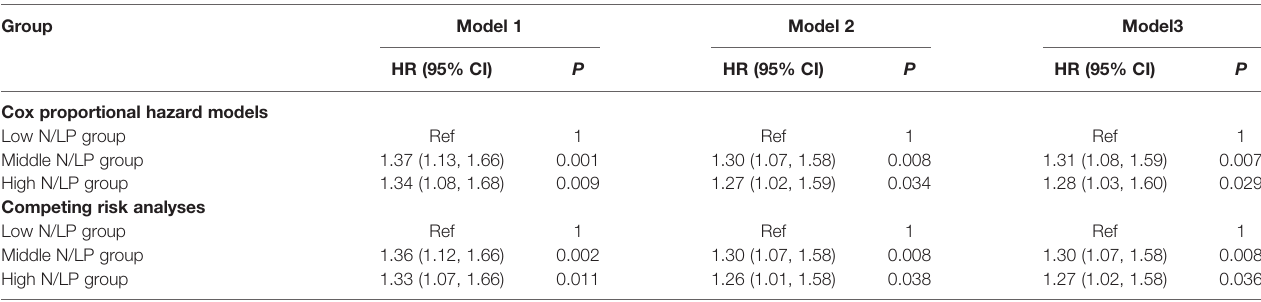
TABLE 2 | The results of Cox proportional hazards models and competing risk analyses.